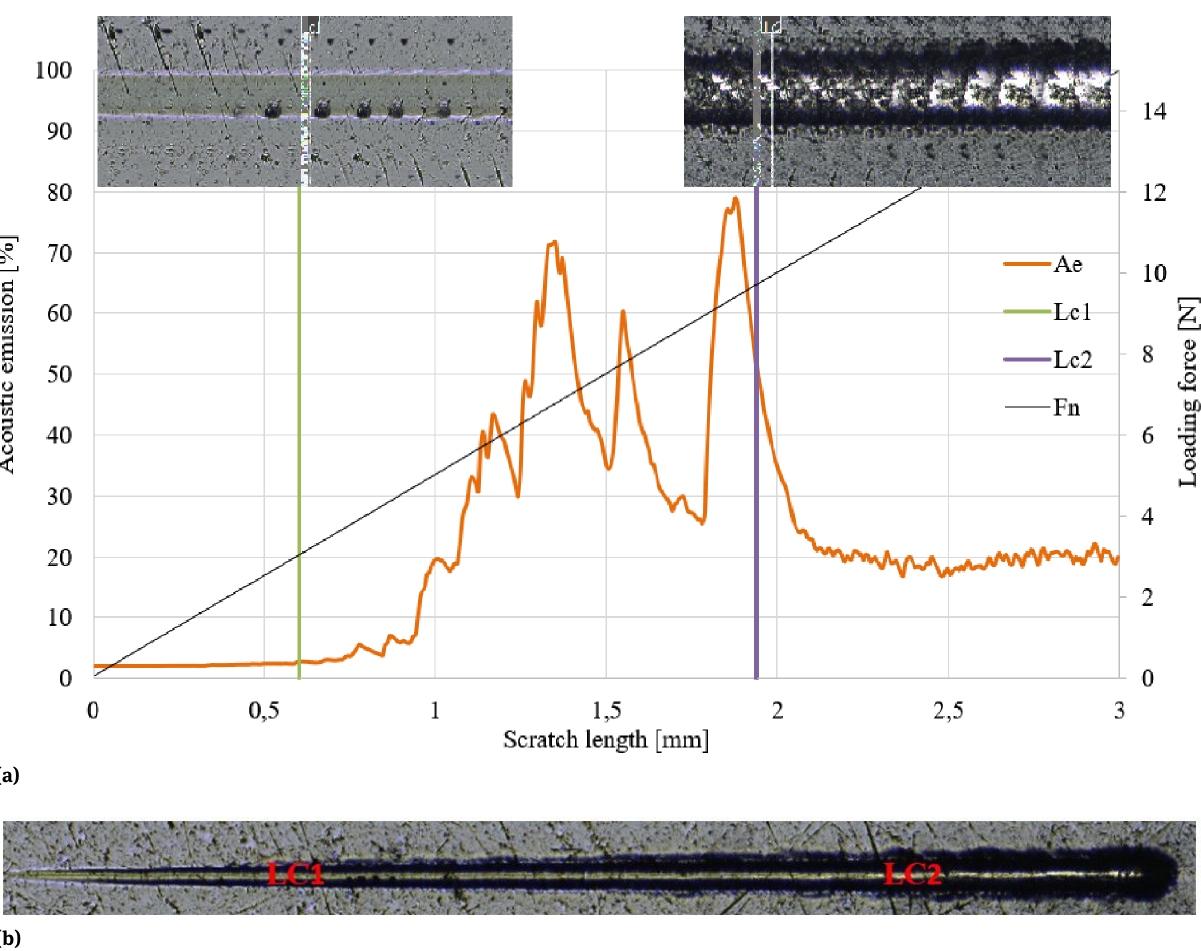
Figure 6: Scratch test results a) graph of variation of loading force and acoustic emission, b) scratch track: first critical load (L C 1 ), second